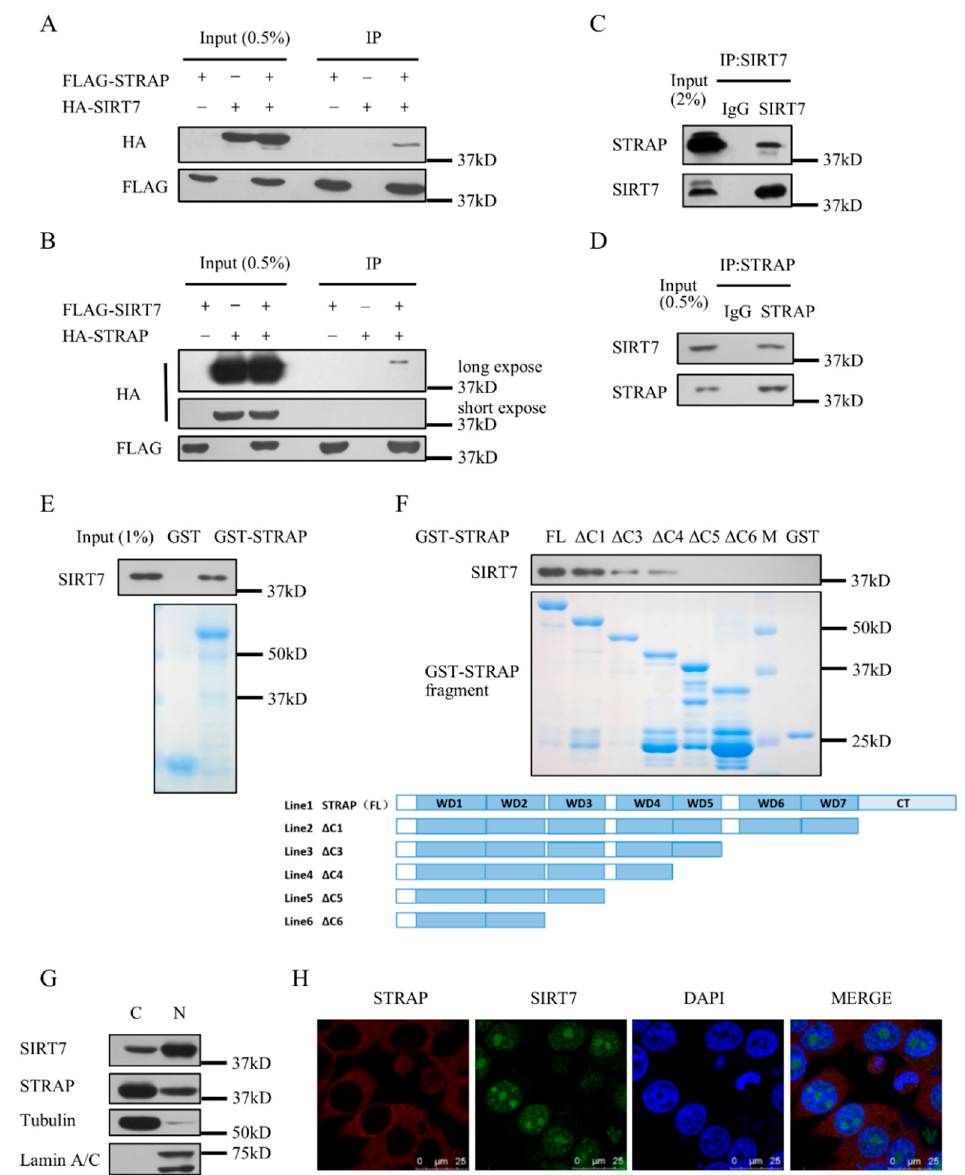
Figure 1. Serine-threonine kinase receptor-associated protein (STRAP) interacts with sirtuin7 (SIRT7) in vivo and in vitro. ( A , B ) STRAP interacts with SIRT7 in vivo. HEK293T cells were co-transfected with tagged STRAP and tagged SIRT7. Whole-cell lysates were immune-precipitated with M2 beads and analyzed by Western blotting with indicated antibodies. ( C , D ) Co-immunoprecipitation of STRAP with SIRT7. Whole HEK293T cell lysates were immune-precipitated with control IgG, anti-SIRT7 or anti-STRAP antibodies, and analyzed by Western blotting with anti-STRAP or anti-SIRT7, respectively. ( E , F ) STRAP interacts with SIRT7 in vitro. GST fusion proteins were generated for full-length STRAP (FL) and di ff erent length of truncated STRAP, ∆ C1, ∆ C3, ∆ C4, ∆ C5, ∆ C6. SIRT7 protein was purified from 293T cells. GST-pull-down assays were performed as described in Material and Methods. ( G ) Subcellular localization of STRAP and SIRT7, revealed by biochemical fractionation. HCT116 cell lysates were analyzed by antibodies as indicated. ( H ) Co-localization of STRAP and SIRT7. HCT116 cells were immune-stained using anti-STRAP or anti-SIRT7 antibodies, followed by Alexa Fluor-594 anti-mouse antibody (for STRAP, in red) or Alexa Fluor-488 anti-rabbit antibody (for SIRT7, in green) and then examined using confocal microscopy. The yellow color in the merged image represents the co-localization of STRAP and SIRT7. Representative images are shown.